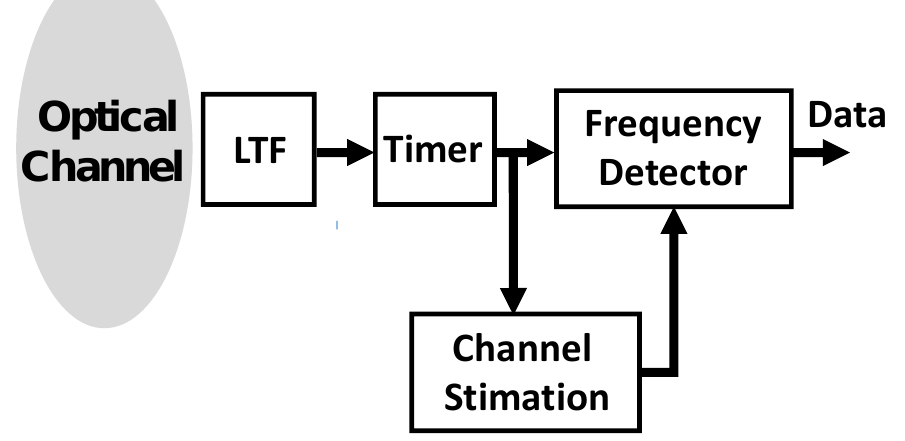
Figure 1. LTF-based VLC